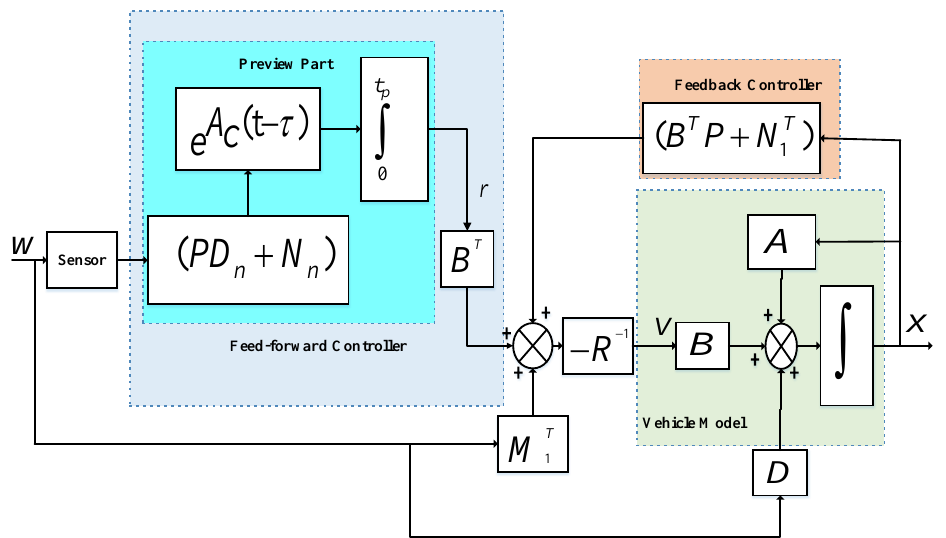
Figure 2. Block diagram schematic comprised of feed-forward to detect the future road disturbance and feedback controller responsible for tracking